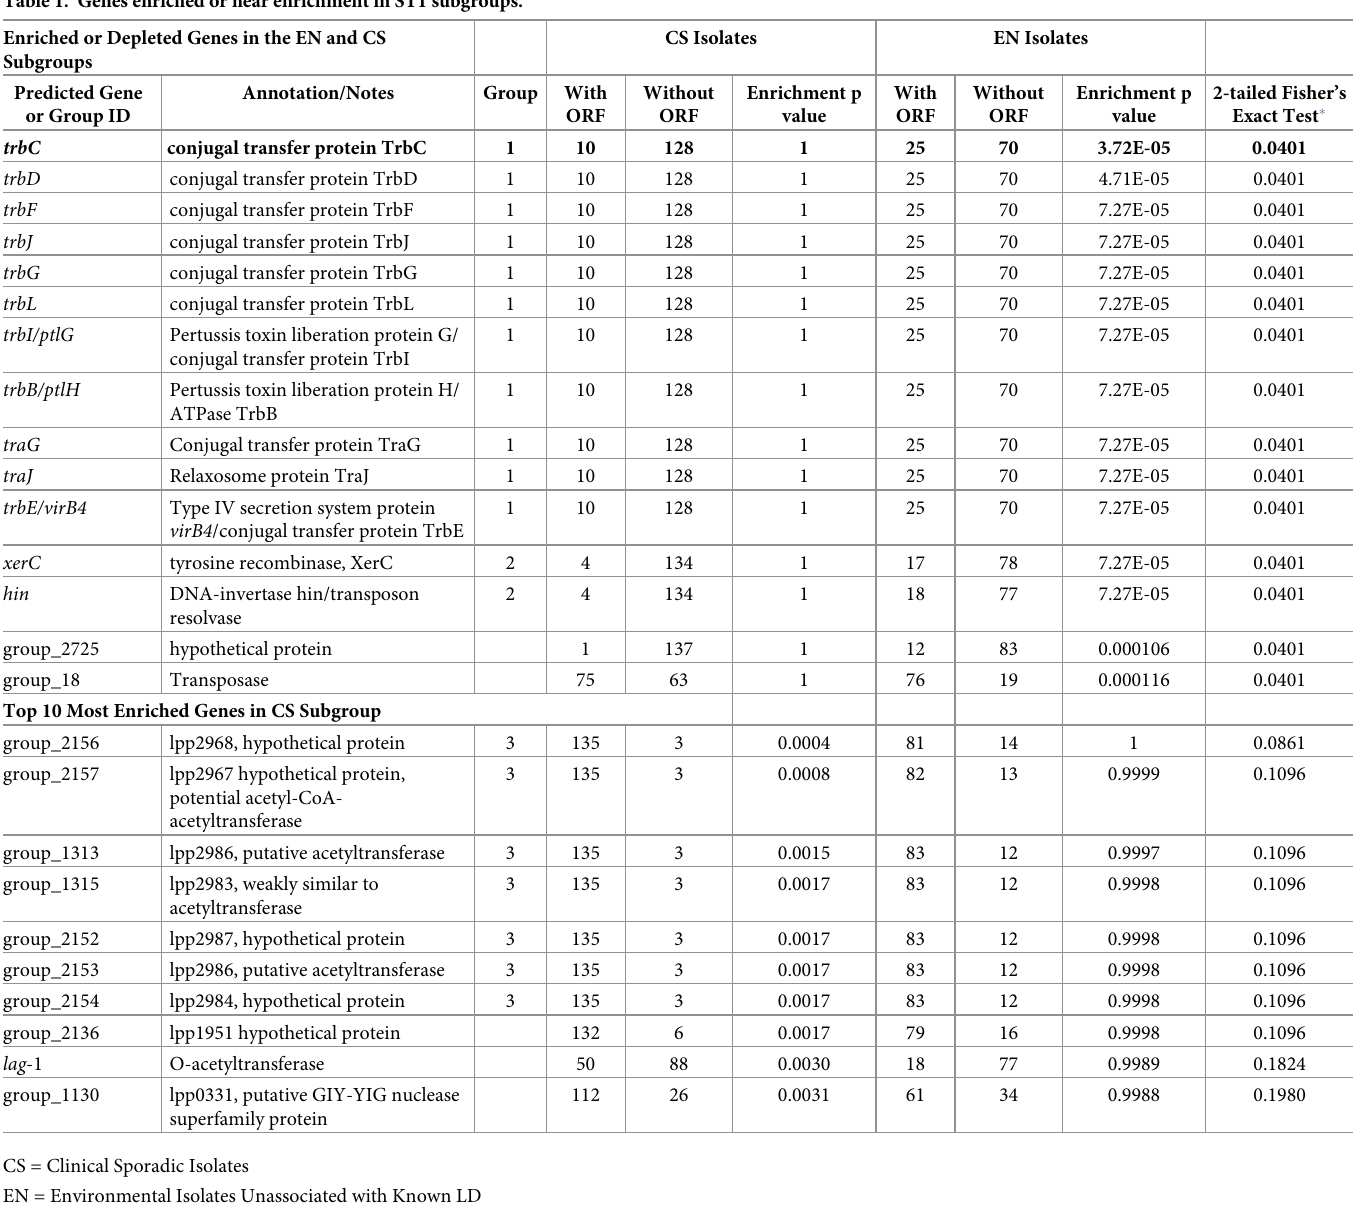
Table 1. Genes enriched or near enrichment in ST1